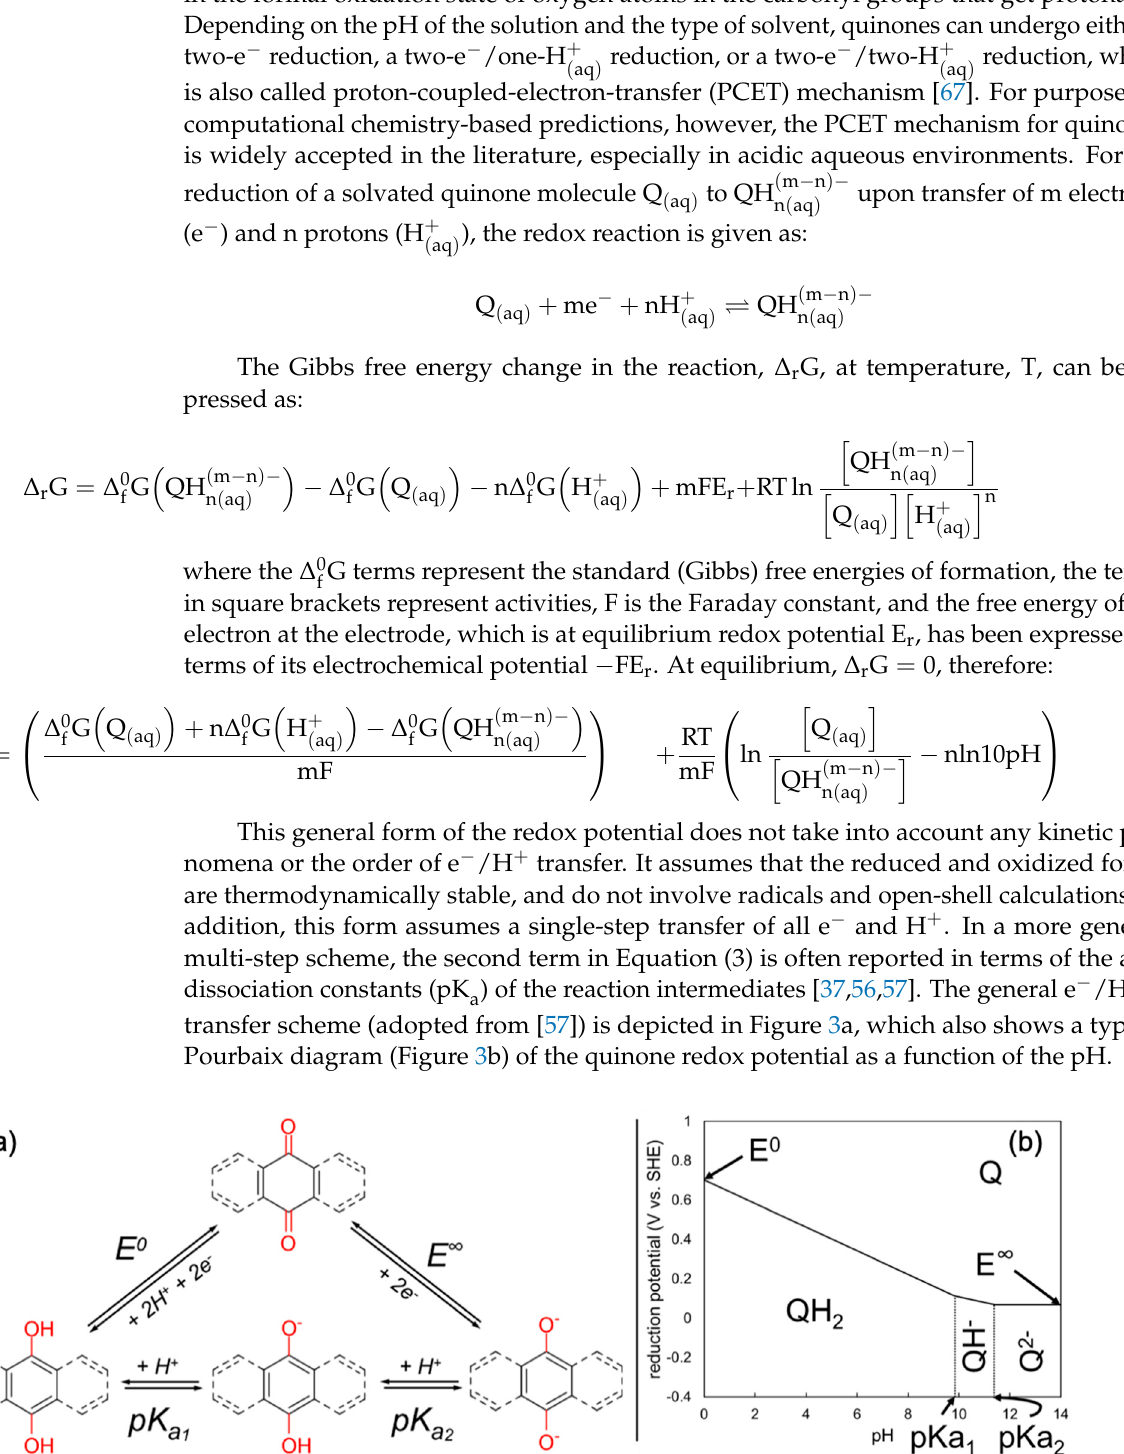
Figure 3. ( a ) Redox and acid − base equilibria between benzoquinone ( Q ) and hydroquinone in acid (QH 2 ), along with their monodeprotonated (QH − ) or dideprotonated (Q 2 − ) forms. ( b ) Typical Pourbaix diagram of the redox couple, where the regions are marked by the thermodynamically most stable acido − basic forms in the entire pH range. Figure adapted from Gaudin et al. [57] (under Creative Commons Attribution